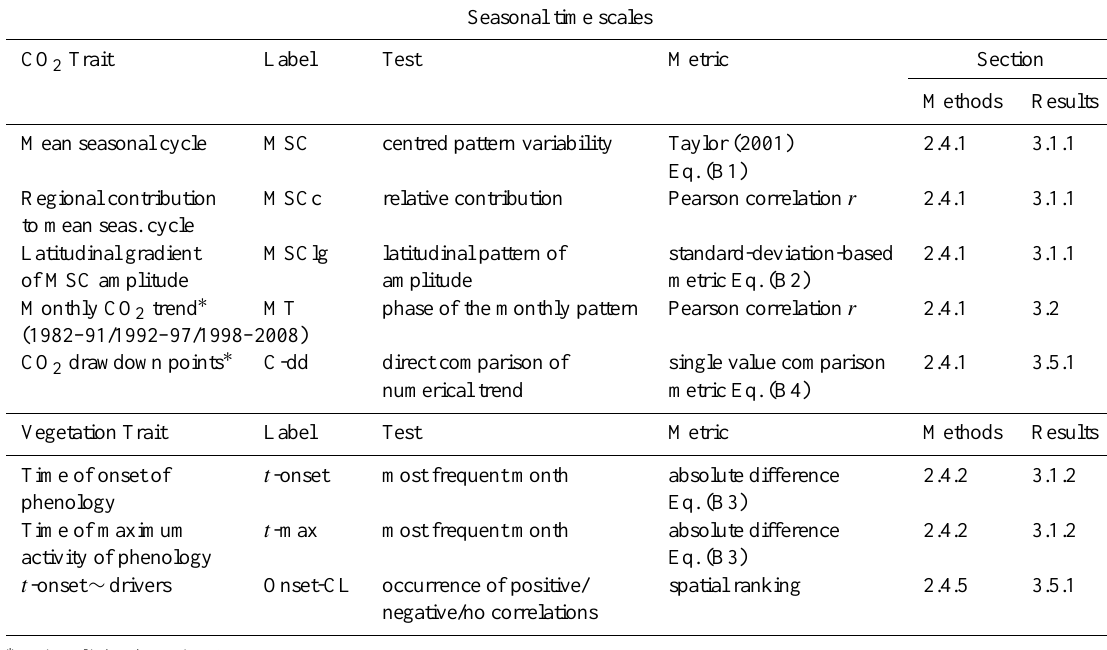
Table 2. List of atmospheric CO 2 and vegetation activity traits used for the analyses at the seasonal time scale. A detailed explanation of metrics can be found in Sect. 2 and Appendices B and C).